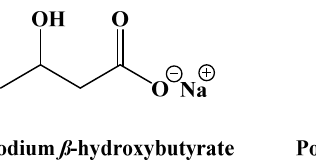
(R)-3-hydroxybutanoate can safely induce ketosis while on a normal diet over 28 days of